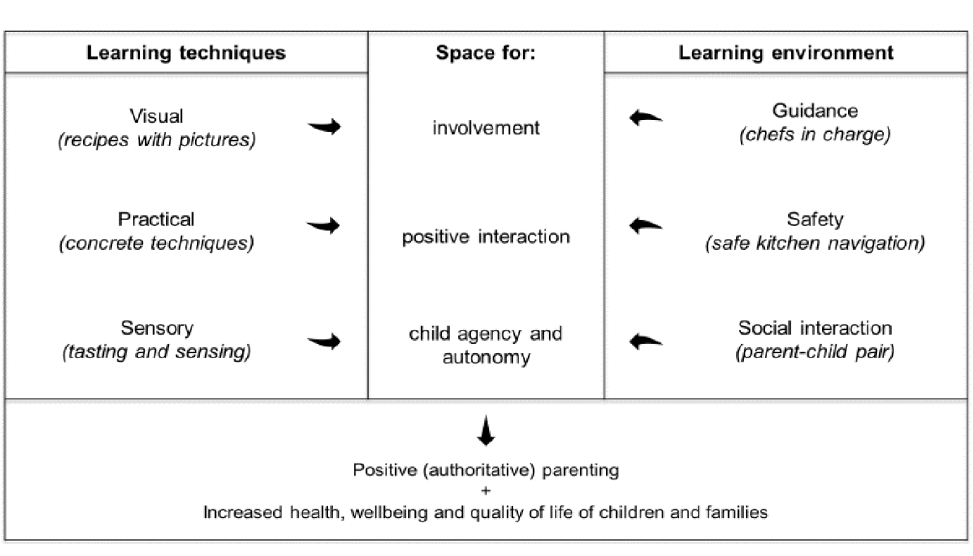
Figure 4. A model showing how learning techniques and learning environment support involvement, positive interaction and child agency, which stimulate positive parenting and thereby may increase family health and